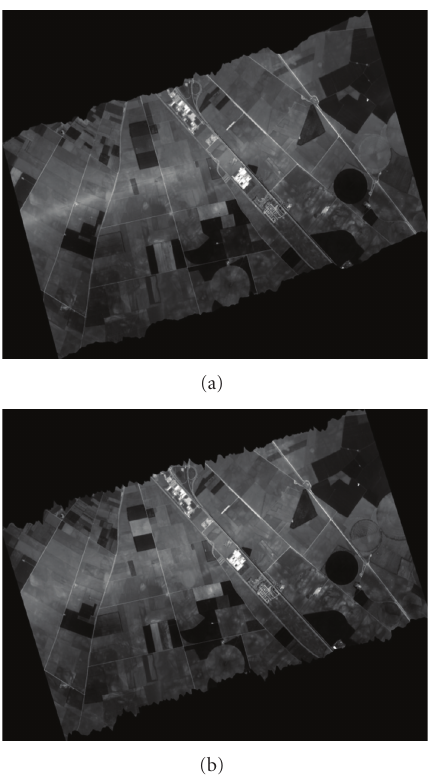
Figure 3: Barrax geocorrected images used in the experiments: (a) data acquired from the first overpass; (b) data acquired from the second